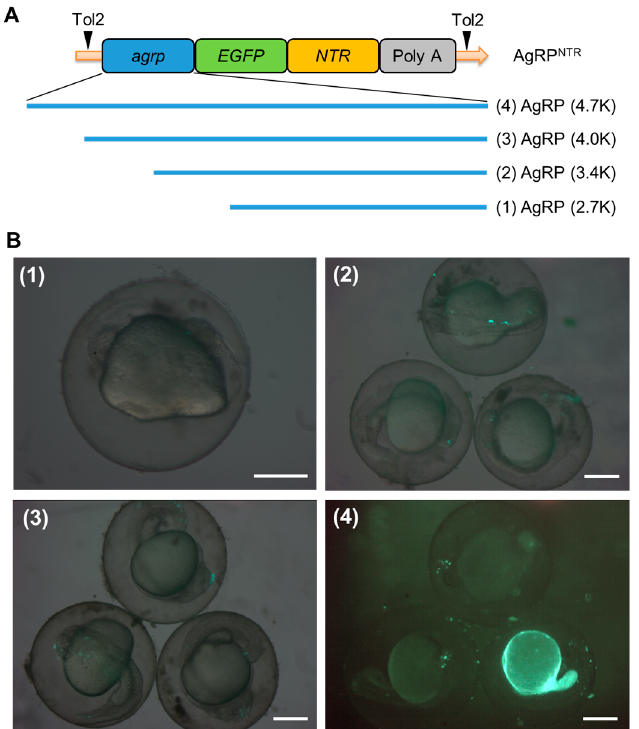
Figure 1. Transient expression analysis of the agrp -enhanced, green, fluorescent protein-nitroreductase ( agrp-EGFP-NTR) deletion constructs. ( A ) Schematic diagram of the DNA construct used to generate AgRP NTR (Tg[ agrp-EGFP-NTR ]) transgenic zebrafish. AgRP (4.7K)-EGFP-NTR contains a 4749 bp 5 (cid:48) flanking region of the agrp gene, and EGFP-NTR fusion has an in-frame 24 bp region downstream of the agrp translational start site. ( B ) Each deletion construct was generated as described in Section 2.2 for functional analyses of the promoter. A total of 4.6 nL (15 ng/ µ L) of the deletion constructs for ( 1 ) AgRP (2.7K)-EGFP-NTR, ( 2 ) AgRP (3.4K)-EGFP-NTR, and ( 3 ) AgRP (4.0K)-EGFP-NTR and the full-length construct for ( 4 ) AgRP (4.7K)-EGFP-NTR were microinjected into one-cell stage embryos. EGFP signal was observed in 36 h post-fertilization (hpf) embryos injected with these constructs via fluorescence microscopy. Scale bar: 200 µ